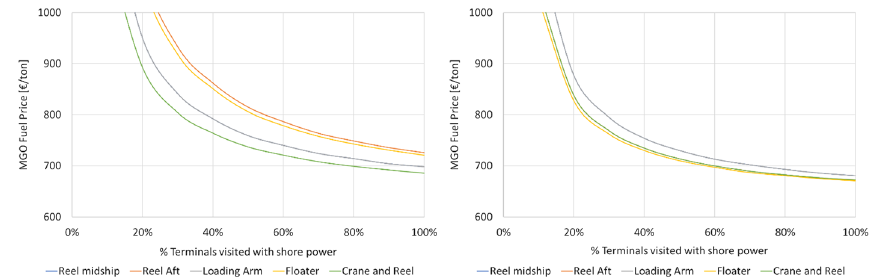
Fig. 4 Break-even fuel price in function of terminals with shore power (Shortsea left, Parcel right)